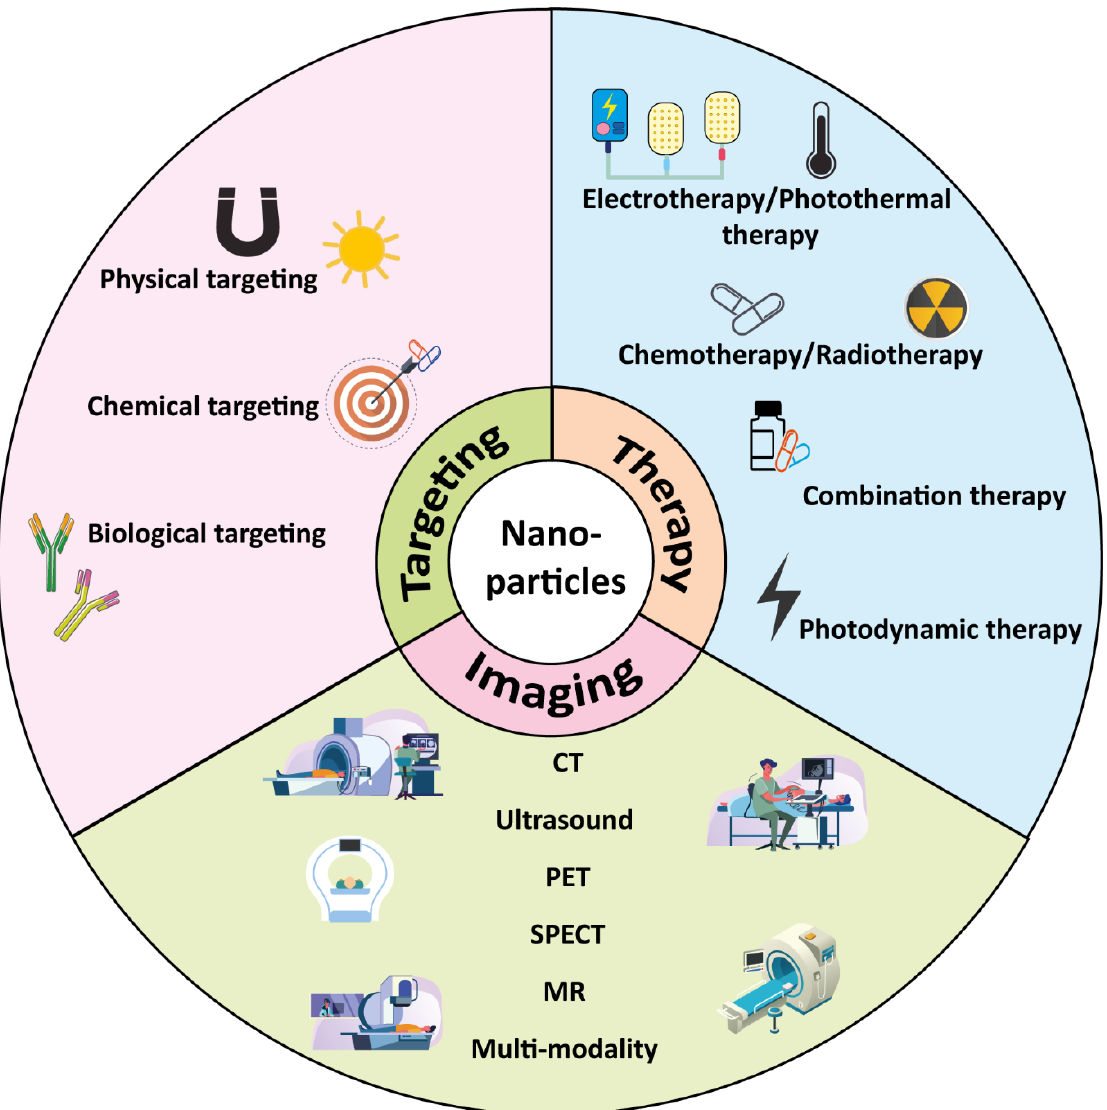
Figure 1. Applications of nanoparticles (NPs) in the field of biomedicine. NPs can be used for in vitro and in vivo targeted drug delivery, therapy and imaging. Multimodal imaging refers to the production of signals that can be detected by more than one imaging technique, for example, the combination of magnetic and radioactive substances to be detected by PET/MRI or PET/CT. Many NP formulations are multimodal and multifunctional. The latter refers to NPs that combine multiple objectives, such therapy and imaging. This figure was prepared using a template on the Servier medical art website (http://www.servier.fr/servier-medical-art, accessed on June 2021).